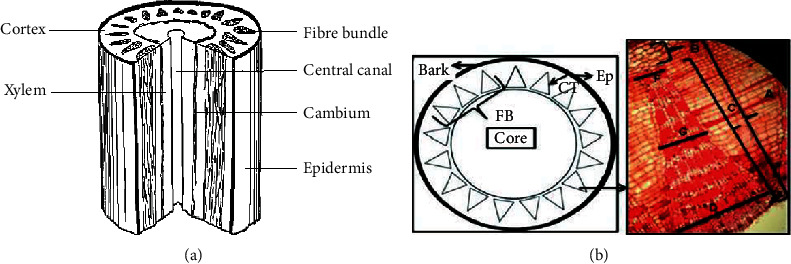
(a) Anatomy of the jute stem [42] and (b) pattern of fiber cell distribution in cross section of jute plant [15]. FB: fiber bundle; Ep: epidermis; CT: cortex; A: total bark diameter; B: difference between fiber wedge tip; C: average length of fiber bundle; D: average width of fiber bundle at base; F: average width of fiber bundle at top; G: average width of fiber bundle at middle.